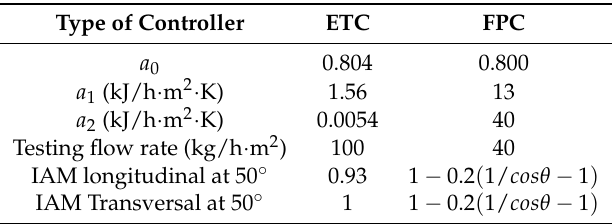
Table 1. Technical specifications of collectors.